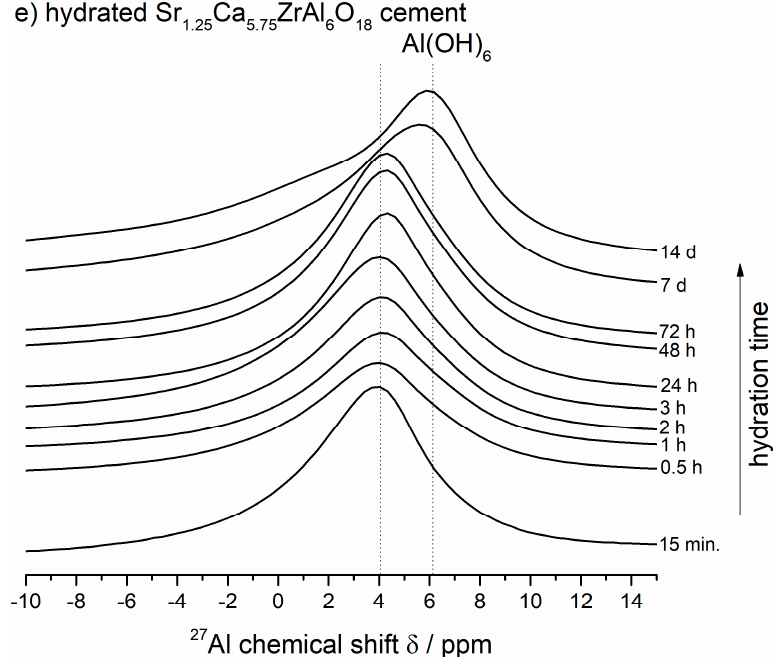
Figure 4. ( a , b ) The room-temperature 27 Al MASNMR spectra of unhydrated Ca 7 ZrAl 6 O 18 (Sample C) and Sr 1.25 Ca 5.75 ZrAl 6 O 18 (Sample A) cements, and their products of hydration formed between 15 min and 14 d at 50 ◦ C. The arrow means the changes according to the direction of increasing hydration time. ( c ) A comparison of NMR spectra of both cements at 24 h of hydration. ( d , e ) The lines at ca. 4–6 ppm for octahedrally coordinated lattice Al 3 + in calcium aluminate hydrates.